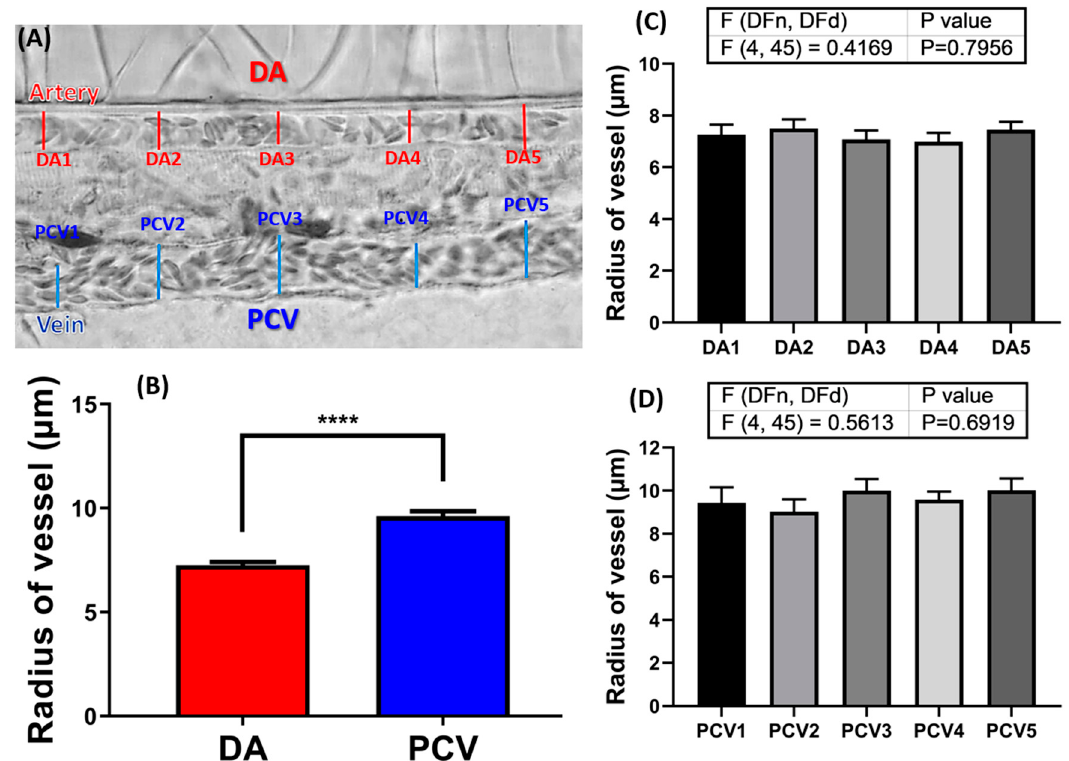
Figure 3. Measurement of the blood vessel radius in zebrafish embryos aged at 72 h-post-fertilization. ( A ) The radius of the dorsal aorta (DA, red color) and posterior cardinal vein (PCV, blue color) were measured at five points from anterior to posterior positions. ( B ) Comparison of the average radius of the DA and PCV in zebrafish embryos. Comparison of five sampling points from anterior to posterior position as indicated in ( A ) for either in ( C ) DA or in ( D ) PCV. Data were compared using one-way